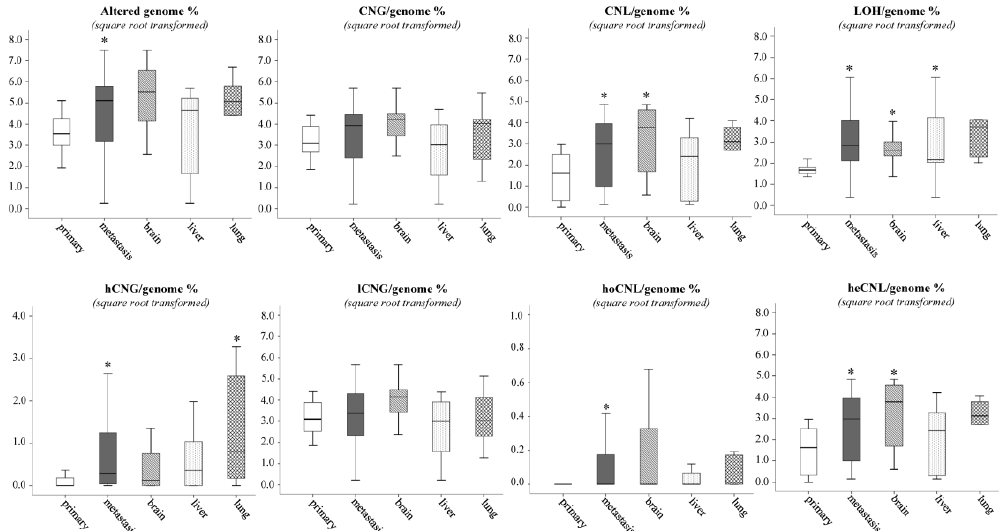
Figure 2. Distribution of CNV types between primary tumors and distant metastases from distinct sites. Asterisk means the level of significance (* p ≤ 0.05). Kruskal–Wallis test was used for the multiple group comparisons, and Mann–Whitney–Wilcoxon test was applied for the primary vs. all metastasis analysis. Abbreviations: CNG, copy number gain (CN > 2); CNL, copy number loss (CN < 2); LOH, loss of heterozygosity; hCNG, high-copy number gain (CN ≥ 4); lCNG, low-copy number gain (4 > CN > 2); hoCNL, homozygous copy number loss (CN = 0); heCNL, heterozygous copy number loss (2 > CN > 0).